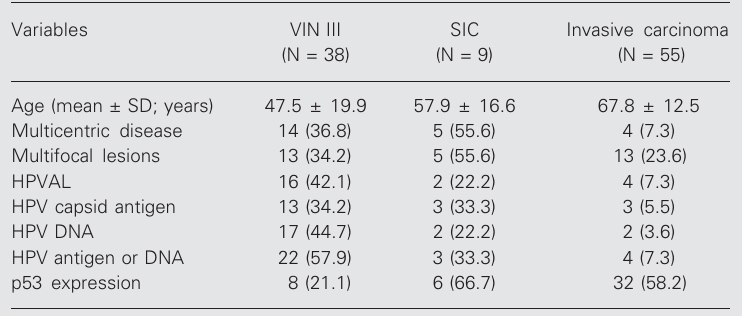
Table 1. Clinicopathological findings of patients with three types of lesions.